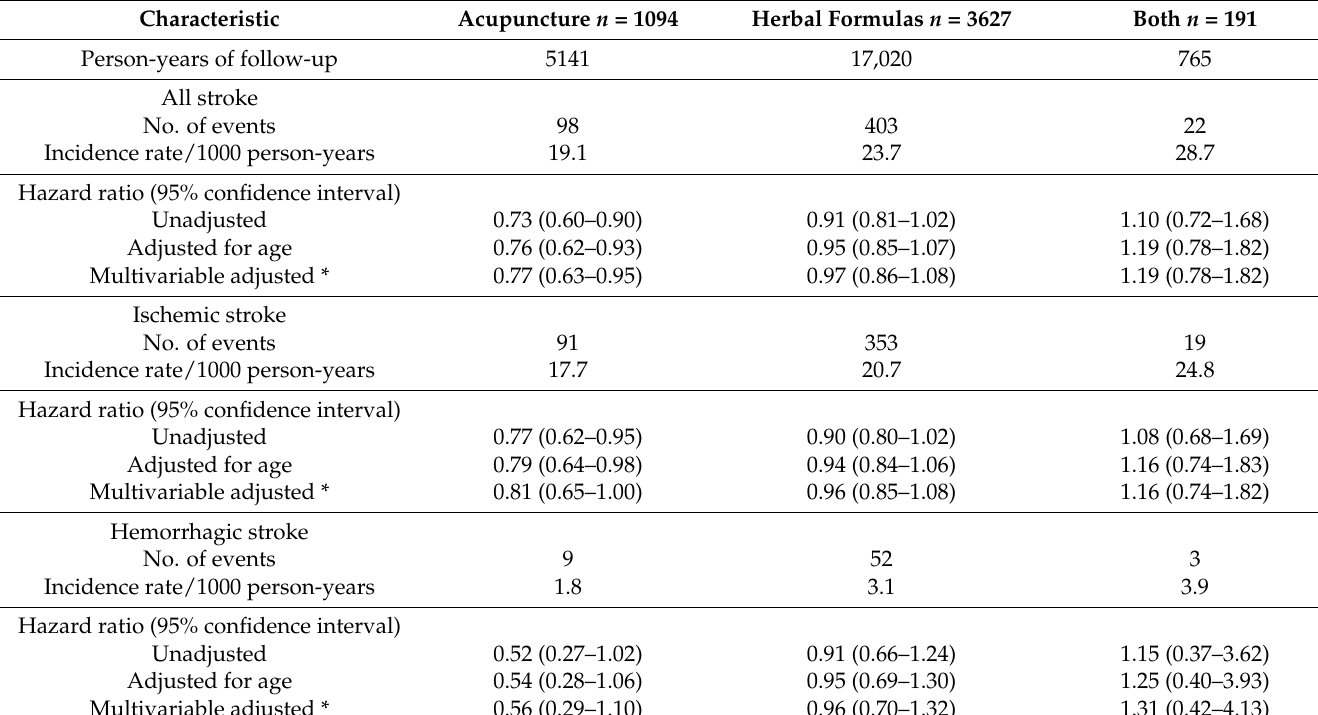
Table 3. Incidence rate and hazard ratio of incidence of stroke associated with TCM